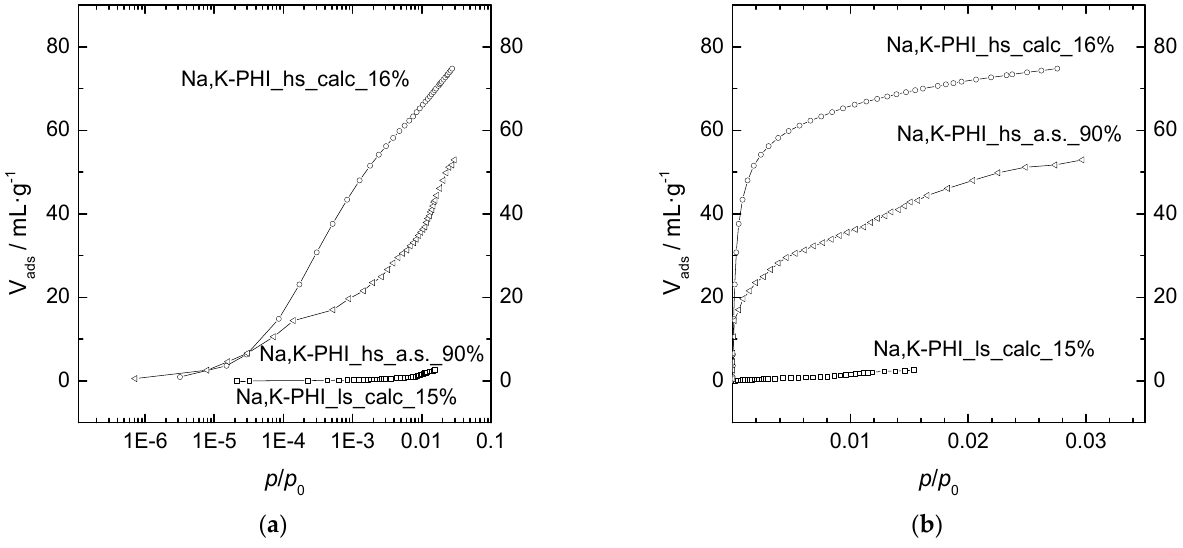
Figure 3. CO 2 physisorption isotherms at 273 K in ( a ) logarithmic scale and ( b ) linear scale for Na,K- PHI_ls_calc_15% ( □ ), Na,K‑PHI_hs_a.s._90% ( ▽ ), Na,K‑PHI_hs_calc_16% ( # ). The textural differ‑ Table 3. Brunauer-Emmett-Teller (BET) surface area S (BET) and Dubinin-Radushkevich (DR) mi- cropore volume V (DR μ -pore) determined by CO 2 physisorption at 273 K.